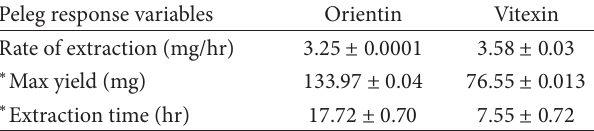
Table 3: Peleg’s maximum yield (mg) of orientin and vitexin and exhaustive time (hr) of dried leaves Clinacanthus nutans water extract.